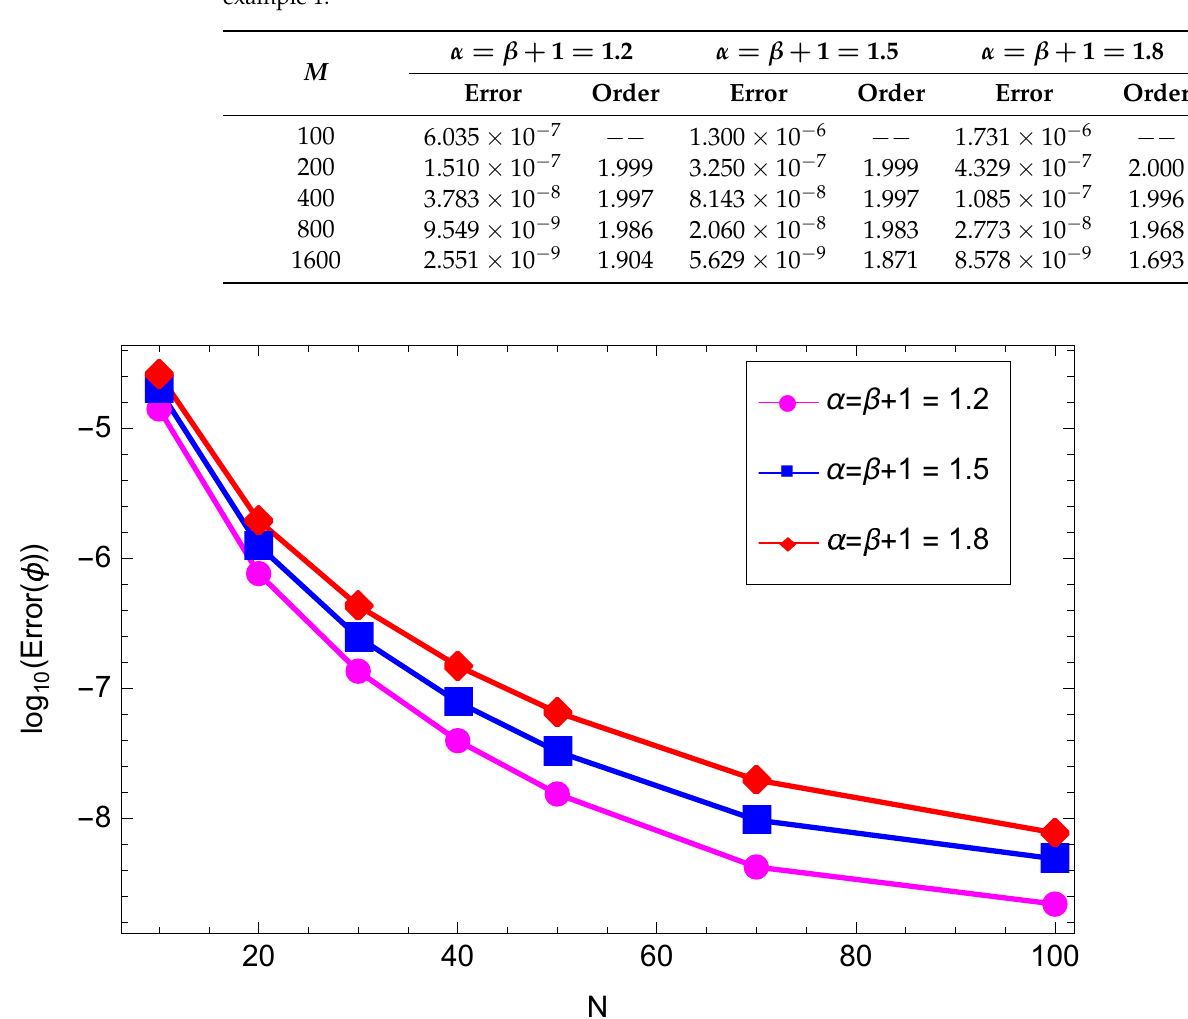
Table 2. The L 2 -errors and the convergence order of ψ versus M and α = β + 1 with N = 100 for example 1.